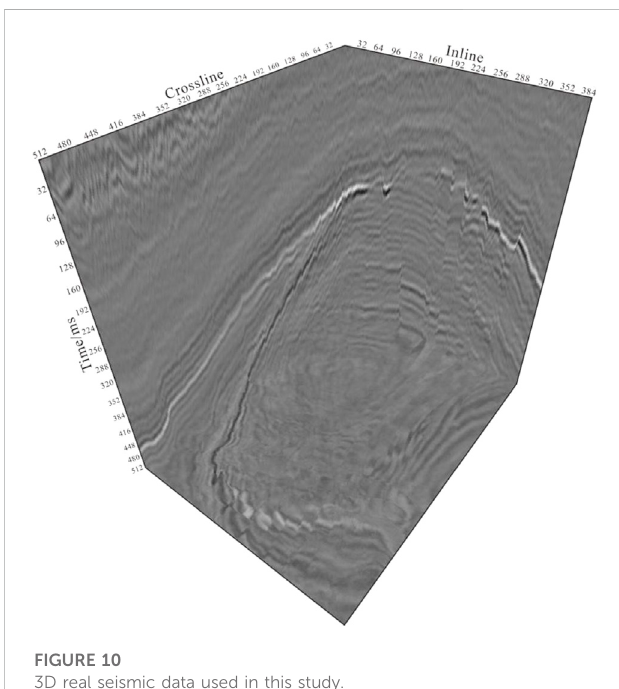
FIGURE 10 3D real seismic data used in this